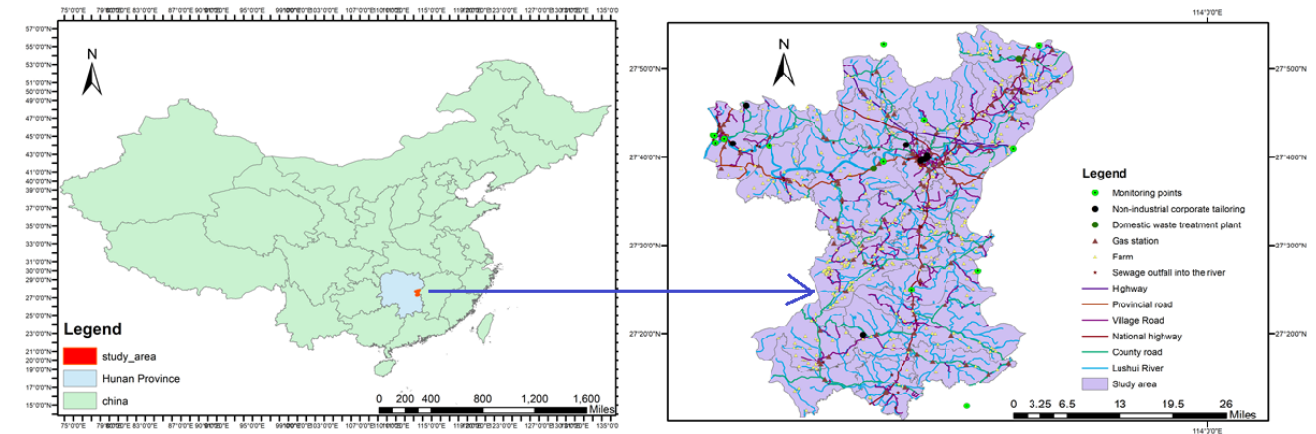
Figure 1. Overview of the research area.